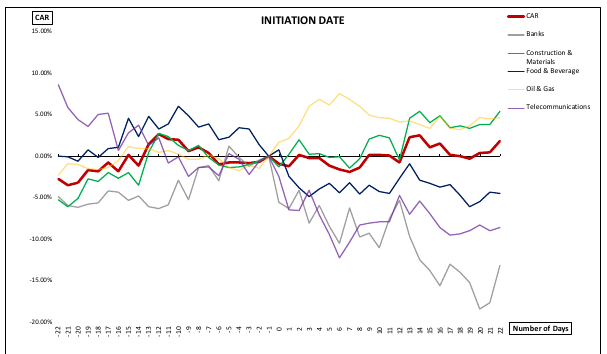
Figure 1: Cumulative abnormal returns around the announcement date of an investigation into collusion by the tribunal